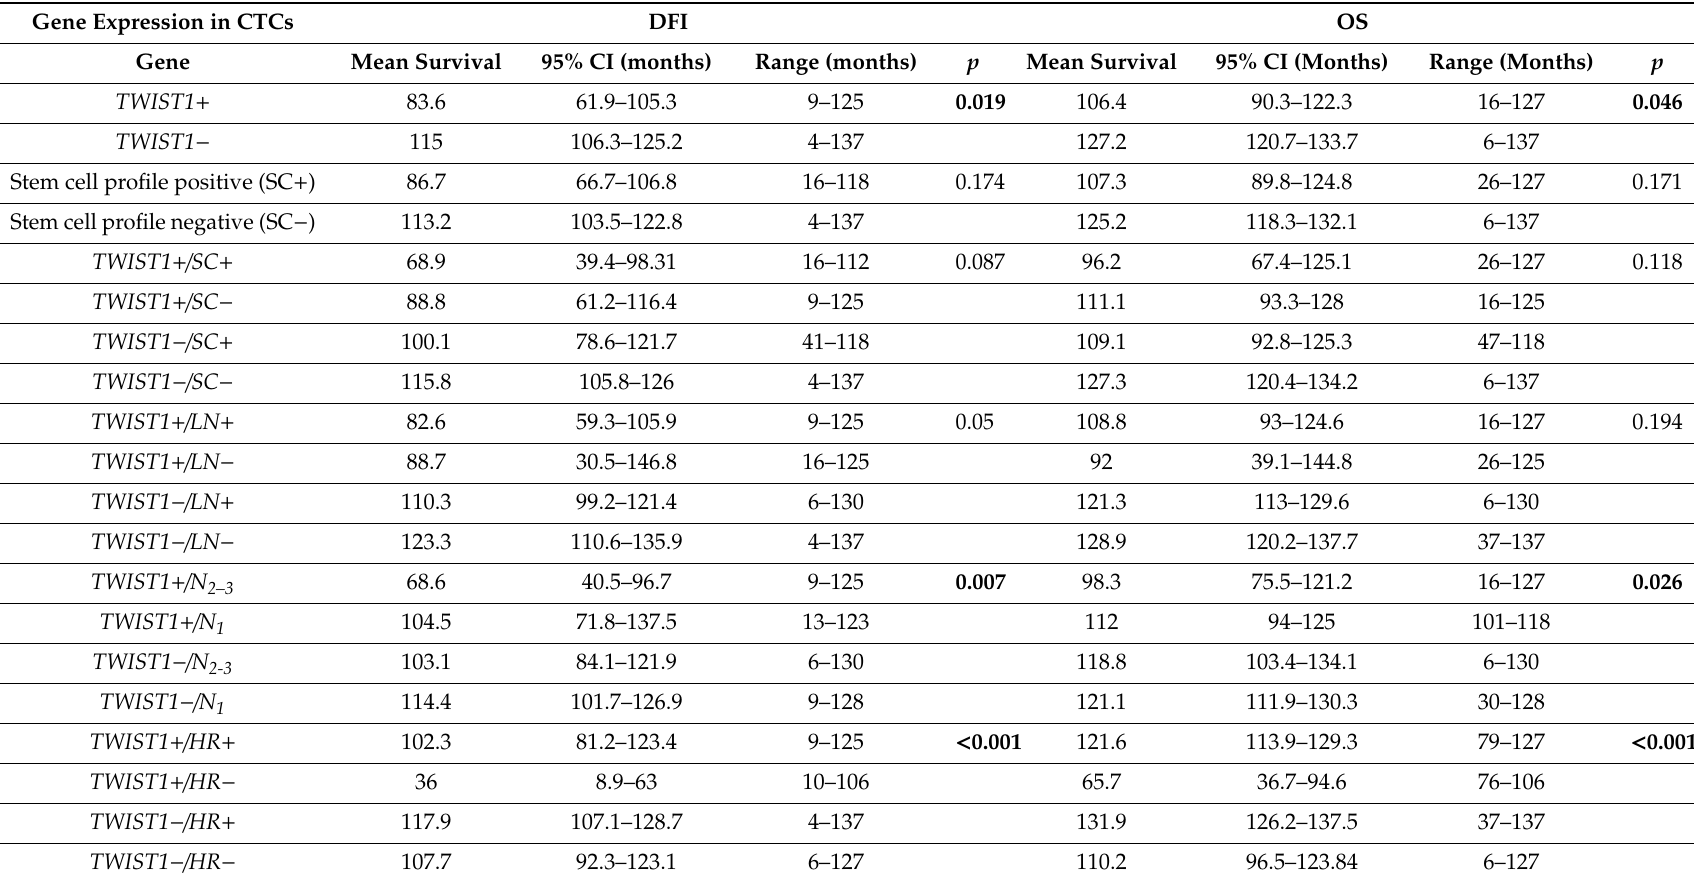
Table 2. Gene expression in CTCs in respect to DFI and